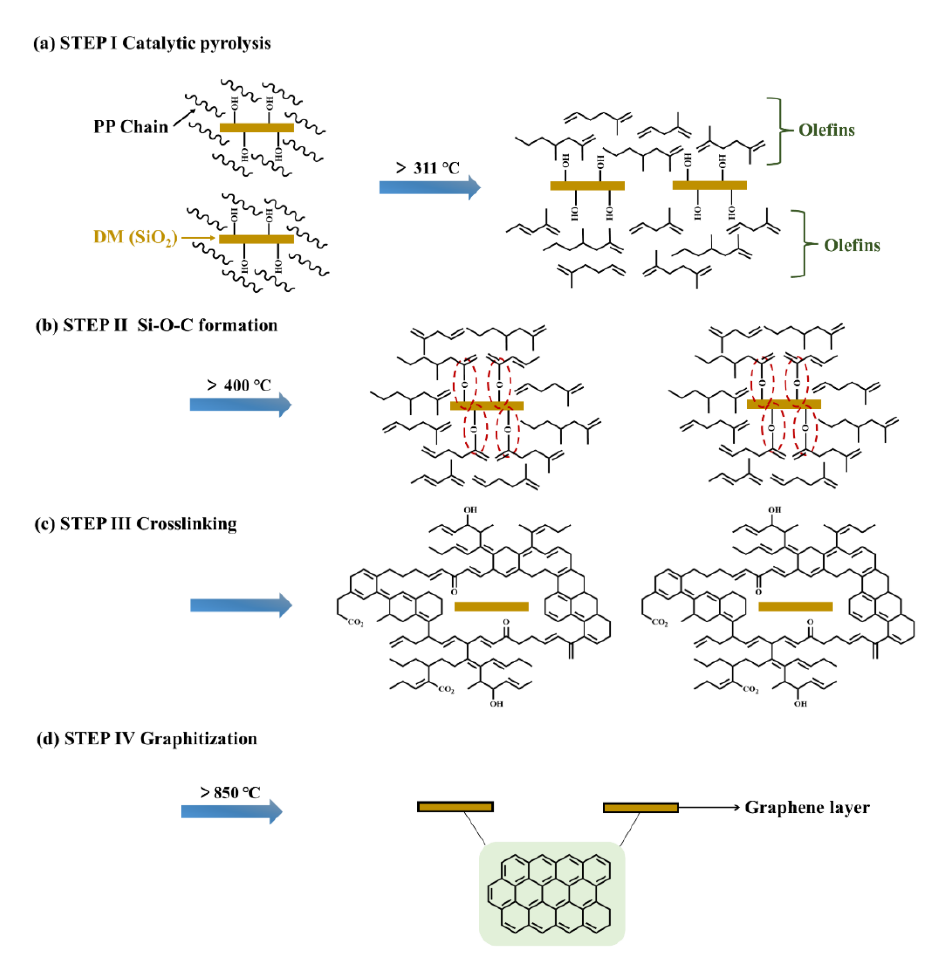
Figure 6. Schematic of the possible mechanism of graphene growth during the pyrolysis process.